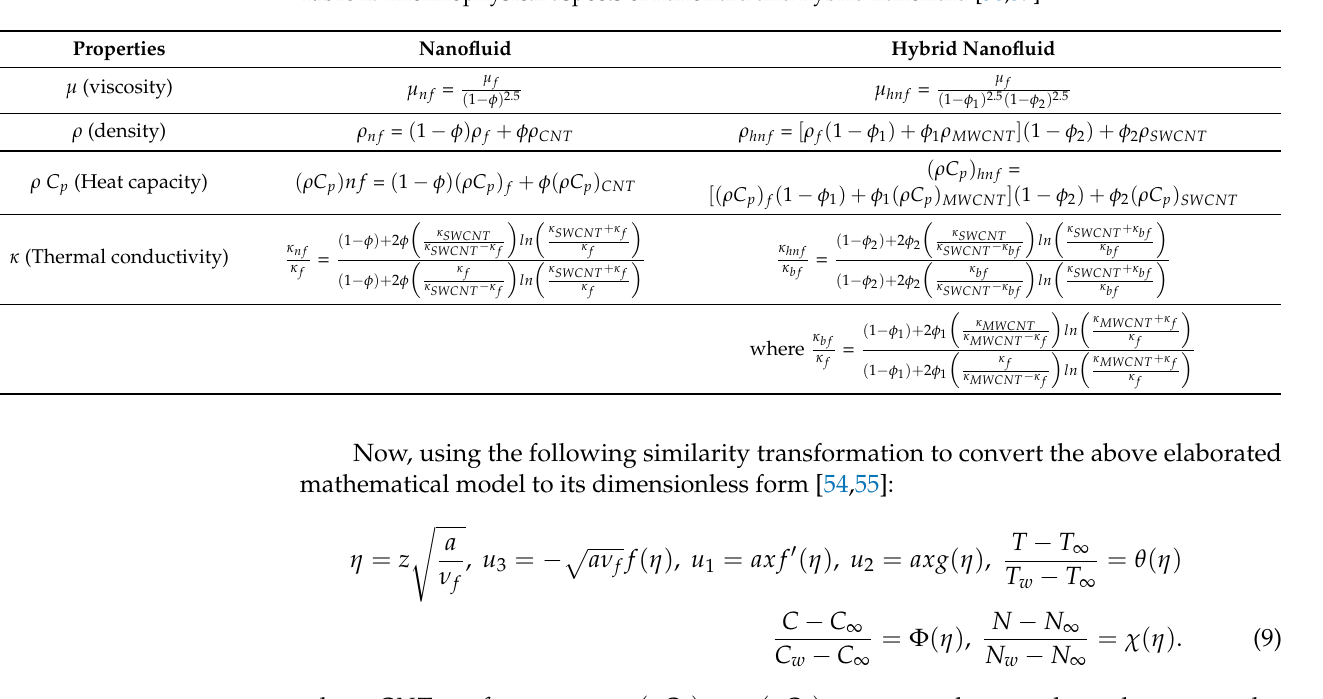
Table 2. Thermophysical aspects of nanofluid and hybrid nanofluid